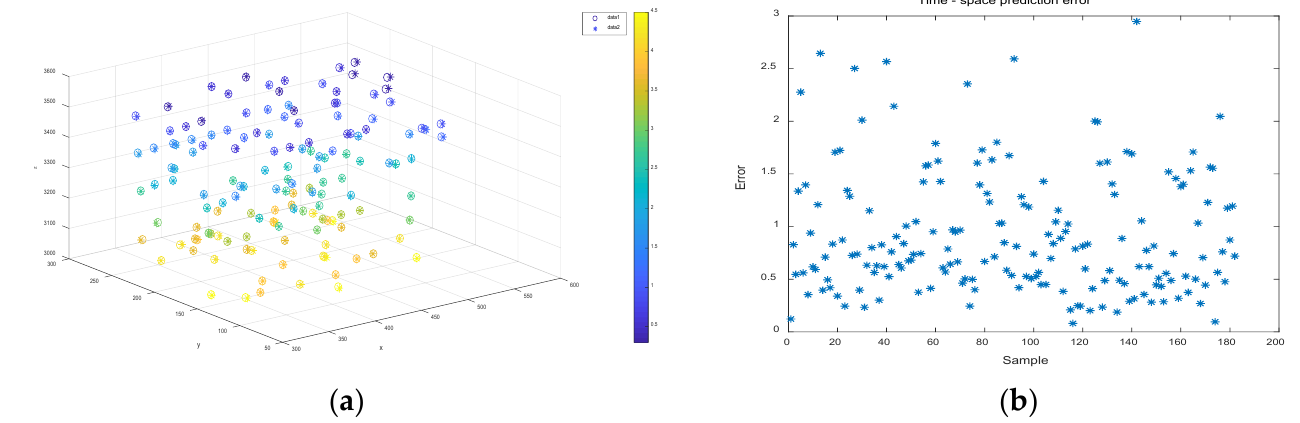
Figure 10. Time-space localization prediction and error of sample points for speed 40 mm/s sample bank test. ( a ) Four-dimensional positioning prediction results; ( b ) spatio-temporal positioning prediction error.